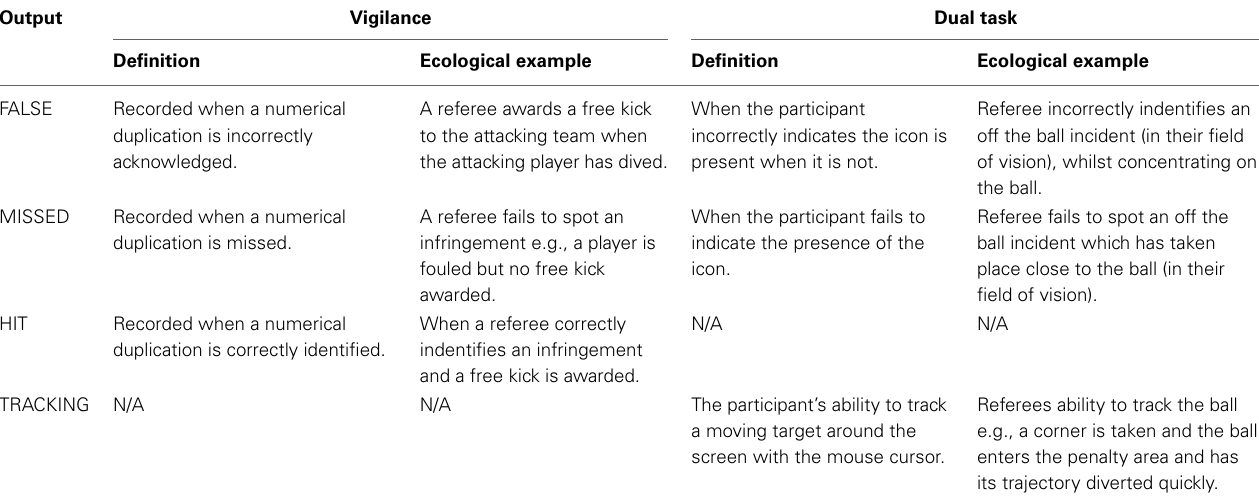
Table 1 | Ecological examples of cognitive tests